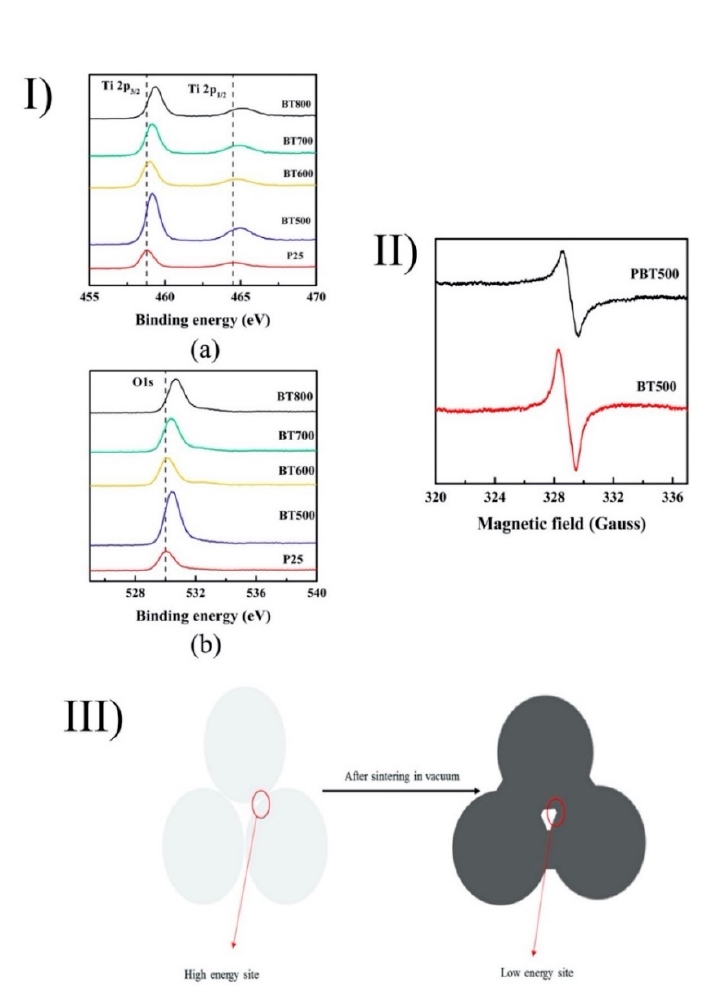
Figure 8. ( I ) XPS spectra of Ti 2p ( a ) and O 1s ( b ) of P25 and black TiO 2 samples. ( II ) Electron paramagnetic resonance (EPR) spectra of compact pellets sintering at 500 ◦ C (BT500) and P25 powder sintering at 500 ◦ C (PBT500) under vacuum condition. ( III ) Scheme of formation of low-energy sites via sintering in a vacuum. Reprinted with permission from [32]. Copyright 2018, American Chemical Society.